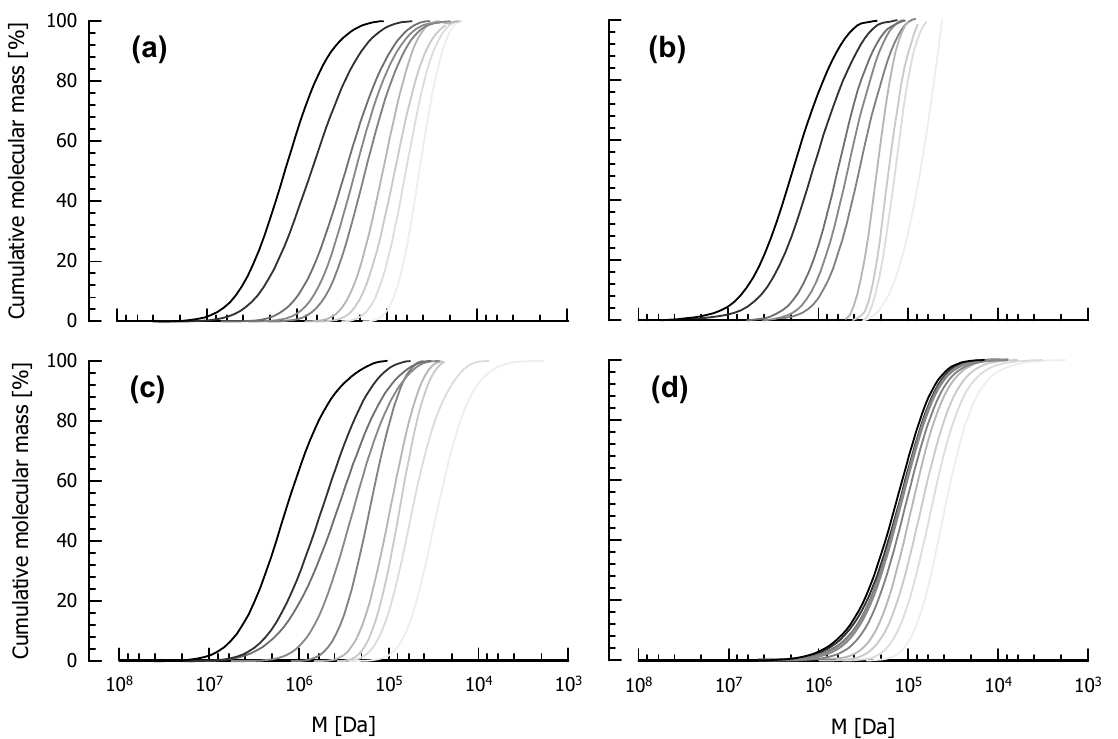
Figure 4. Cumulative molecular mass distributions of DGCC7710 fEPS ( a ), ST143 fEPS ( b ), DGCC7919 fEPS ( c ) and dextran ( d ). EPS solutions (1.0 g/L) were treated with an ultrasonic disintegrator (power density: 114 W/cm²) for 0 s, 5 s, 10 s, 20 s, 30 s, 2.5 min, 5 min, 10 min, 30 min (dark to light grey). M: molecular mass.